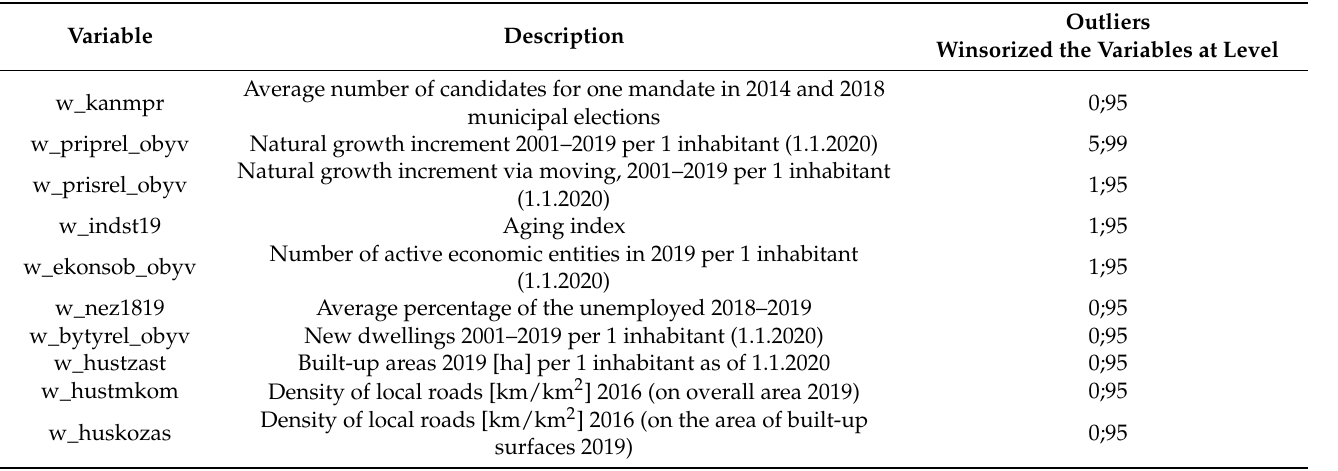
Table 3. Indicators of the present state of the